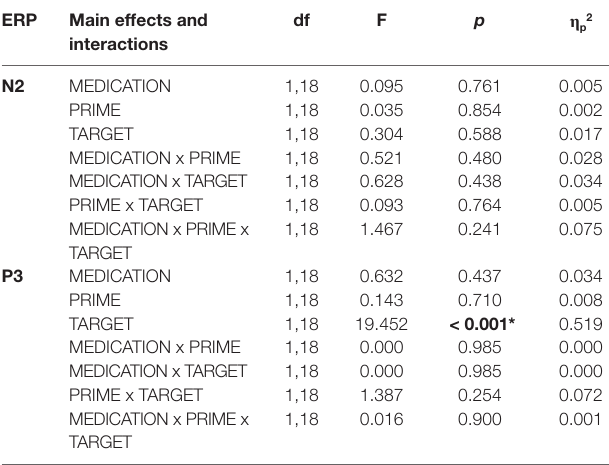
TABLE 4 | Statistical results (main effects and interactions) of ANOVA performed for the frontal N2 and P3 components in experiment 2. ERP Main effects and